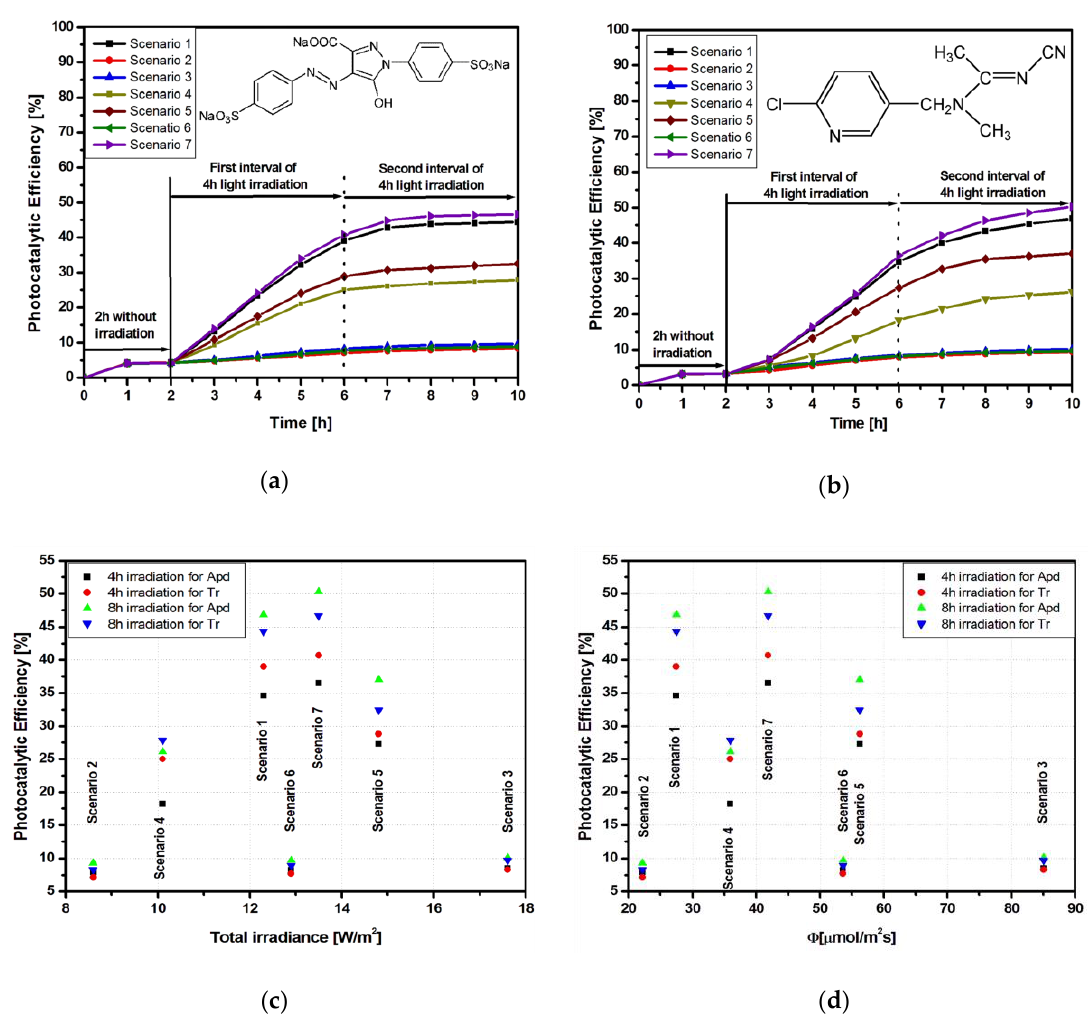
Figure 3. Photocatalytic parameters of the Ti_G sample: ( a ) tartrazine (Tr) photodegradation; ( b ) acetamiprid (Apd) photodegradation; ( c ) total irradiance vs. photocatalytic efficiency, and ( d ) photon flux vs. photocatalytic efficiency. Table 2. Share of UV and Vis radiation and photon flux.